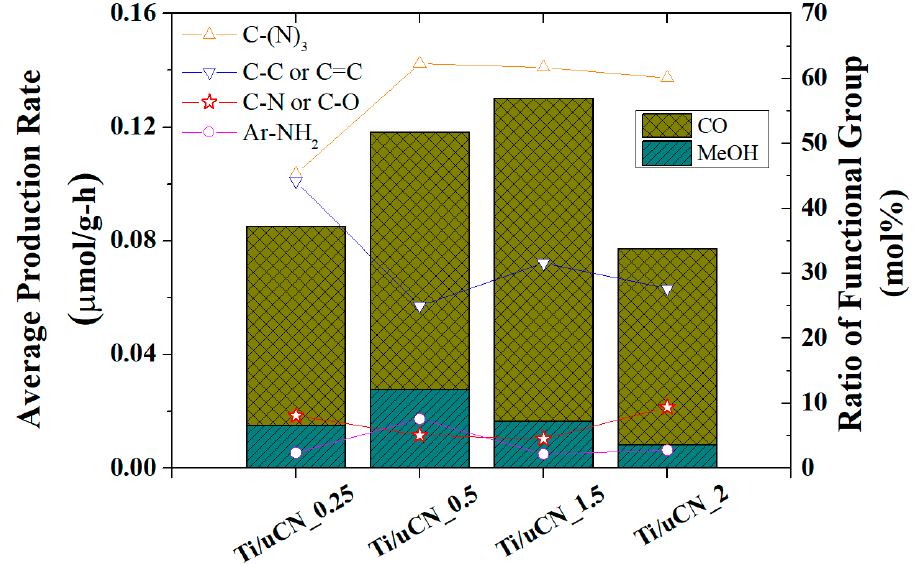
Figure 9. Relationship between initial (2 h) yield of products and surface ratio of carbon-contained functional groups of Ti/uCN_x samples.